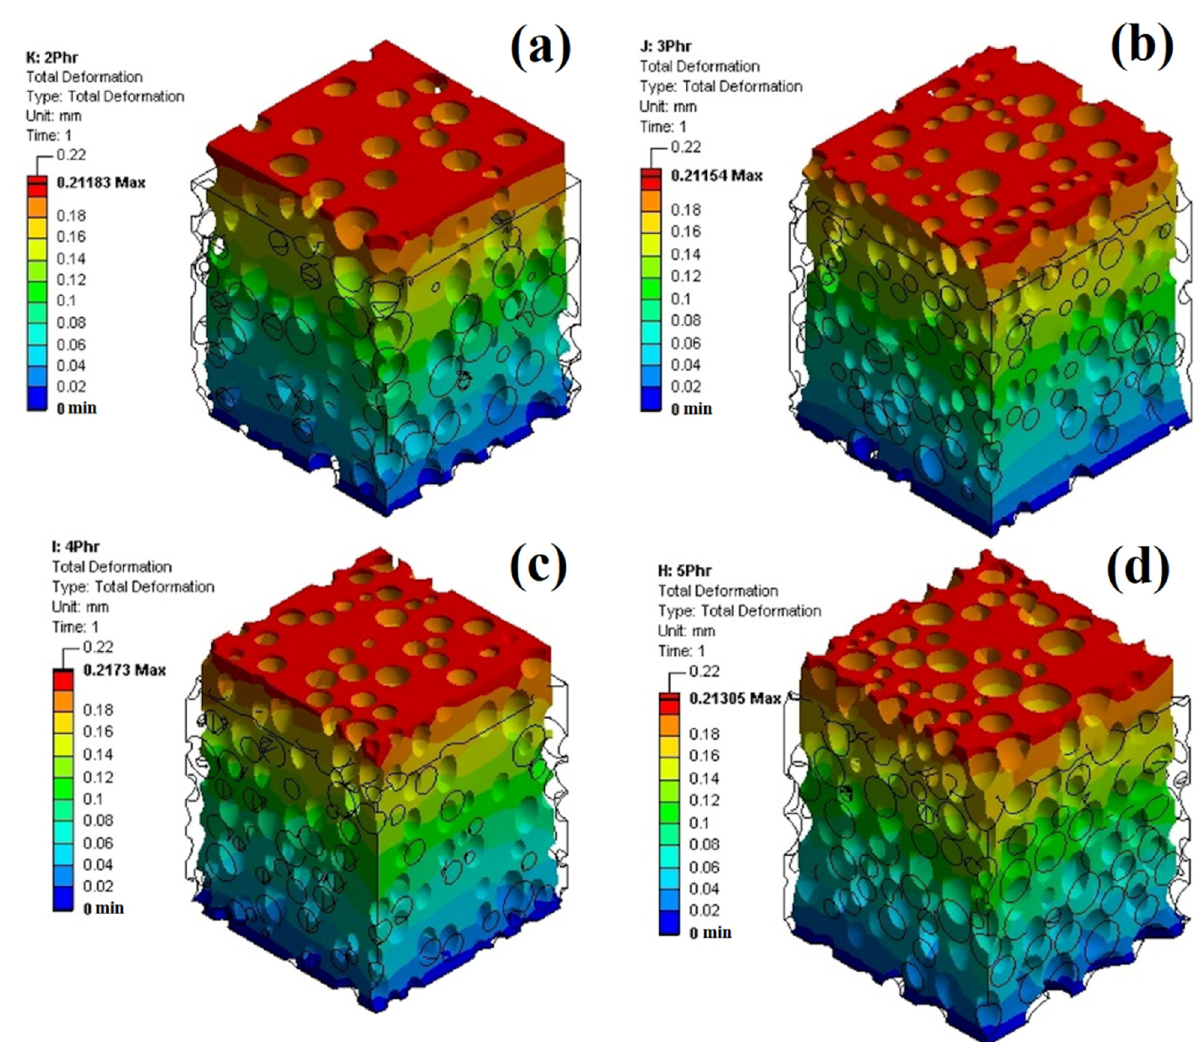
Figure 9. Structural response of POE foams under uniaxial tension loading, after loading (colored structure) and before loading (black line) for foams with different ADC contents: ( a ) 2 phr, ( b ) 3 phr, ( c ) 4 phr and ( d ) 5 phr.